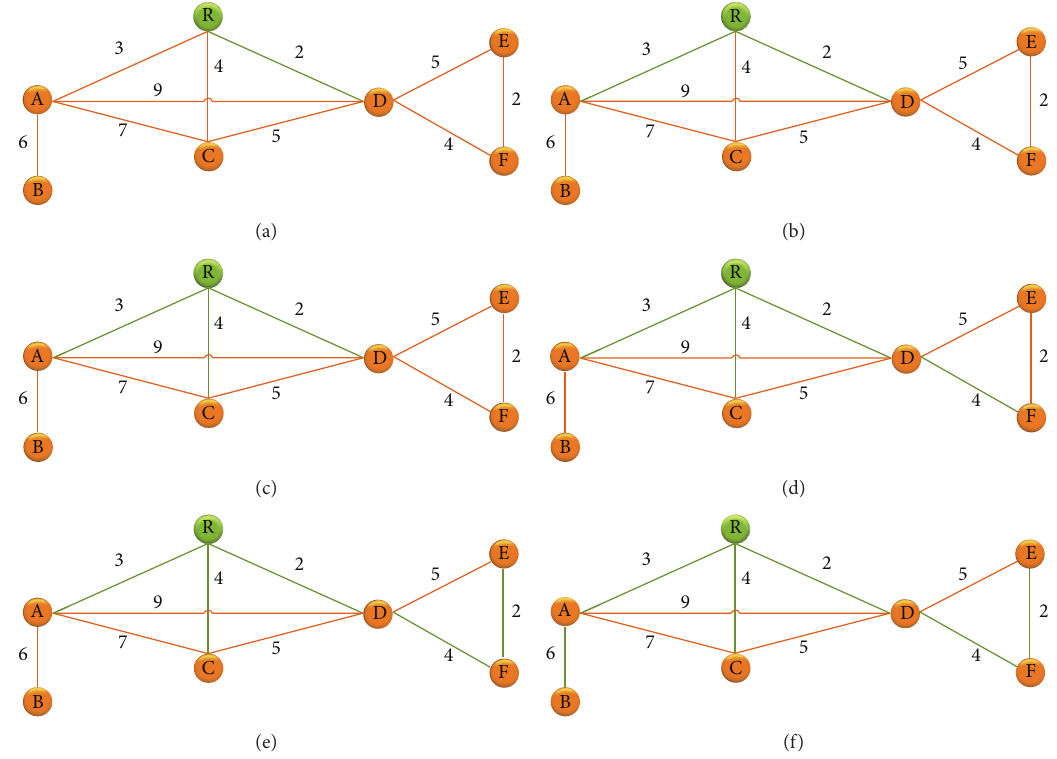
Figure 8: New process of the IPA and final topology structure of the TAN given in Figure 7.